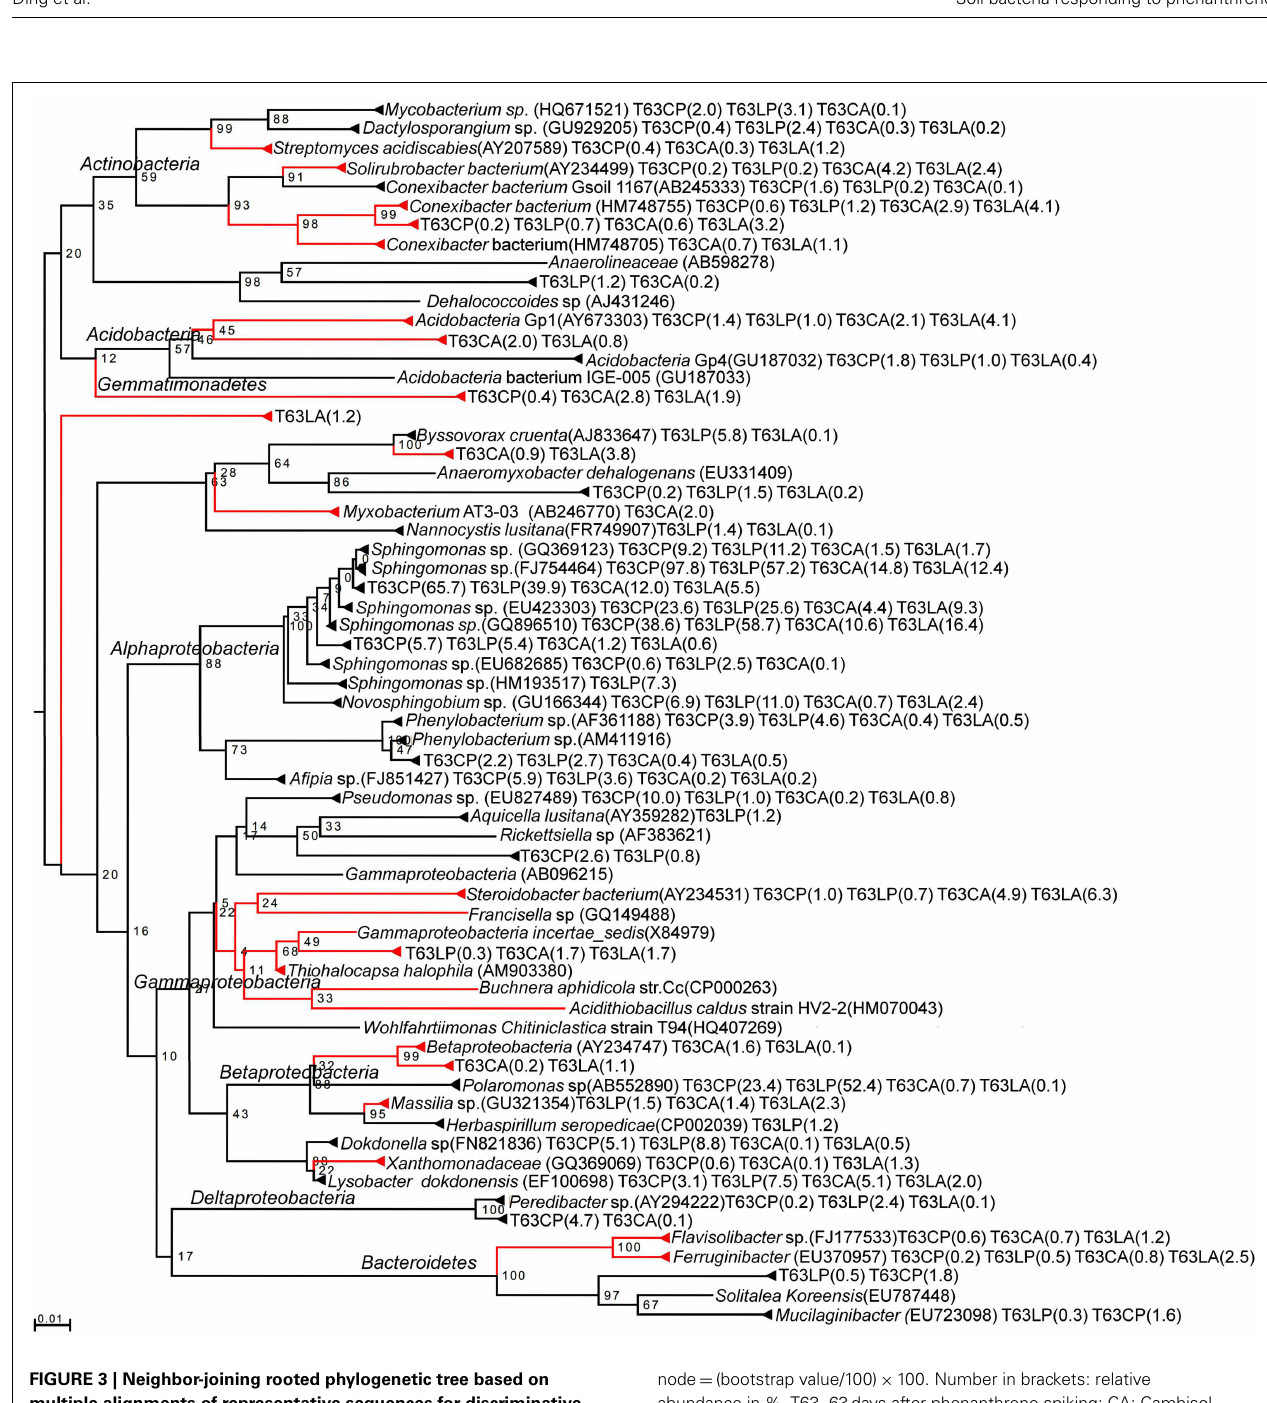
FIGURE 3 | Neighbor-joining rooted phylogenetic tree based on multiple alignments of representative sequences for discriminative OTUs. Red branch: OTUs numerically reduced in the polluted soils. Black branch: OTUs enriched in the polluted soils.Values at each